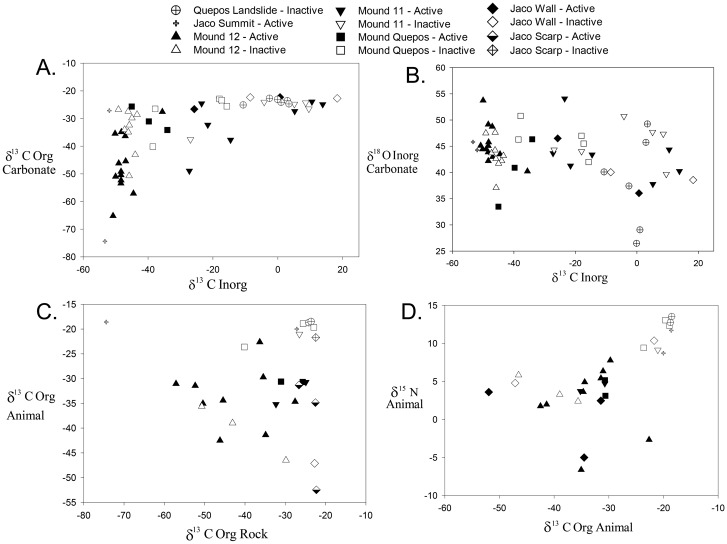

Dual isotope plots of A. Authigenic carbonates; B. Inorganic δ18O and δ13C for individual rocks; C; Average animal δ13C signatures as a function of the δ13Corg value of the rock they were collected on; (D) Macrofaunal δ13C and δ15N values. For A, B, and C each point represents values for a separate rock.